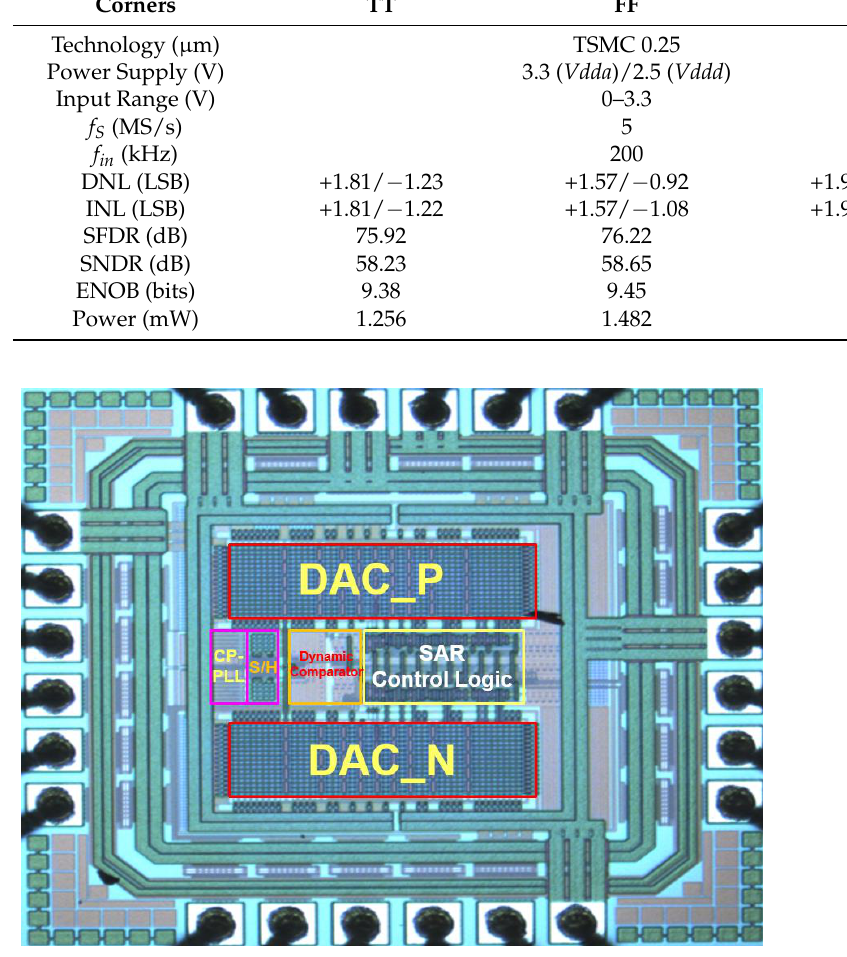
Figure 22. Chip microphotograph of the proposed PLL-SAR ADC.